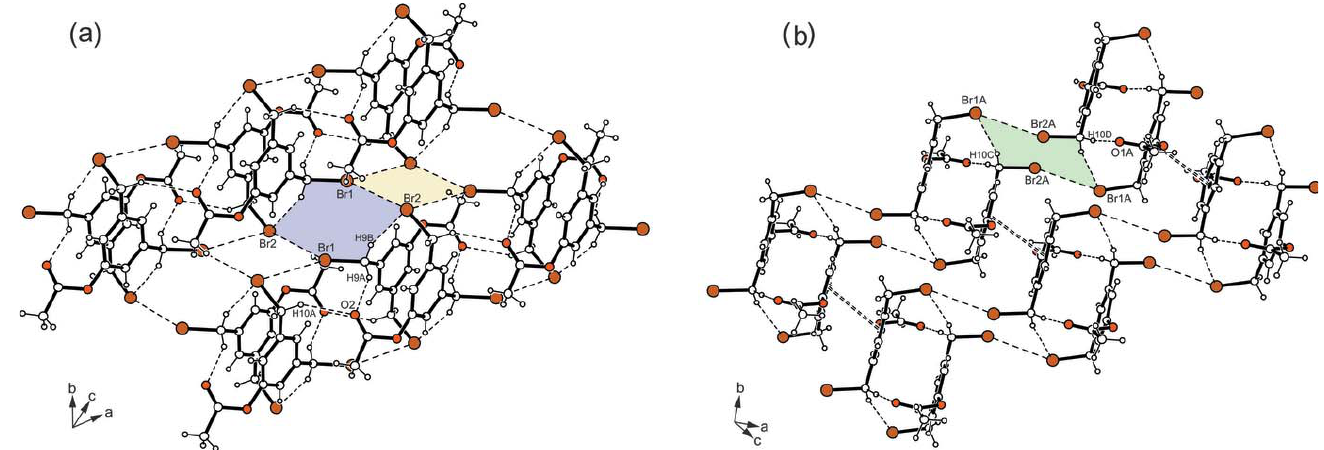
Figure 7 Patterns of intermolecular interactions created by ( a ) molecule A and ( b ) molecule B in the crystal structure of 2 .